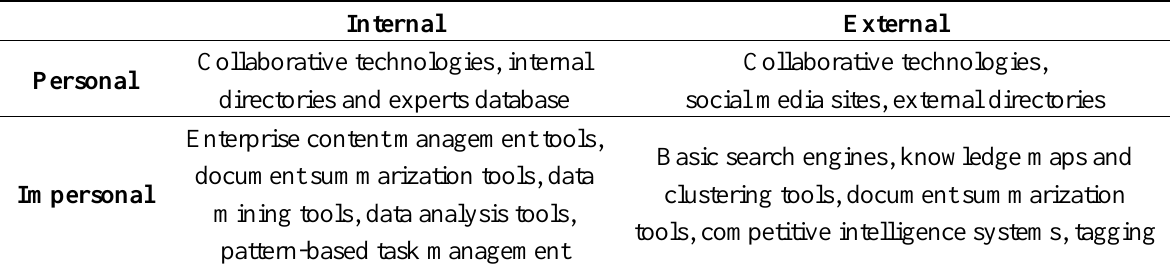
Table 1. Examples of Tools Used for Accessing and Processing